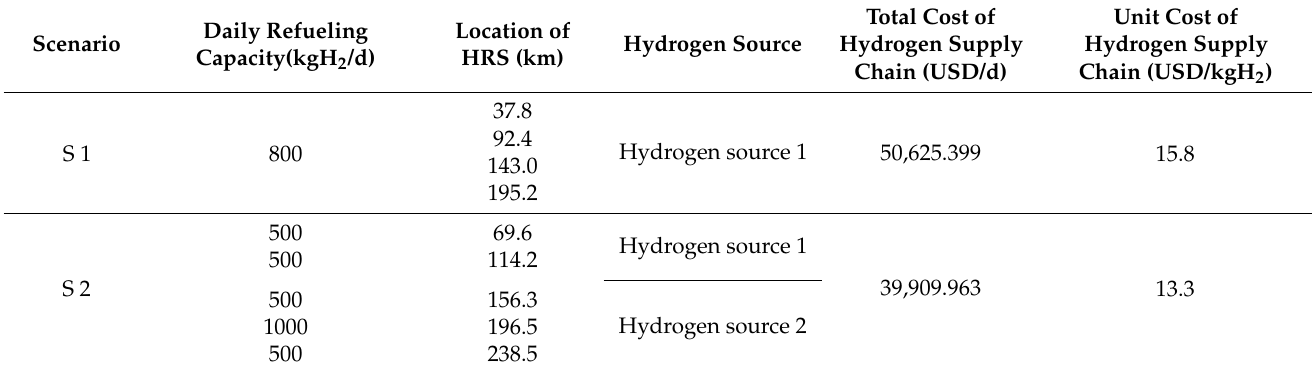
Figure 4. Schematic of specific distribution of hydrogen refueling stations. (Note: This map is made based on the standard MAP GS (2021) 6375 of AmAP, and the base map is not modified). S1: Schematic of specific distribution of hydrogen refueling stations of Scenario 1. S2: Schematic of specific distribution of hydrogen refueling stations of Scenario 2. Table 5. Summary of hydrogen sources and hydrogen refueling